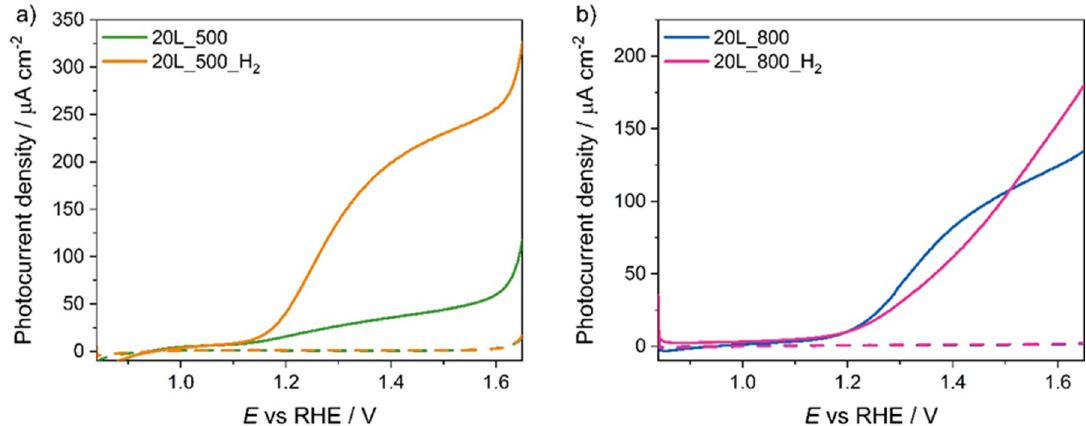
Figure 6. Linear Sweep Voltammetry (LSV) plots of the films annealed at ( a ) 500 °C and ( b ) 800 °C, before and after the hydrogenation treatment. Dashed lines refer to the recorded dark currents.